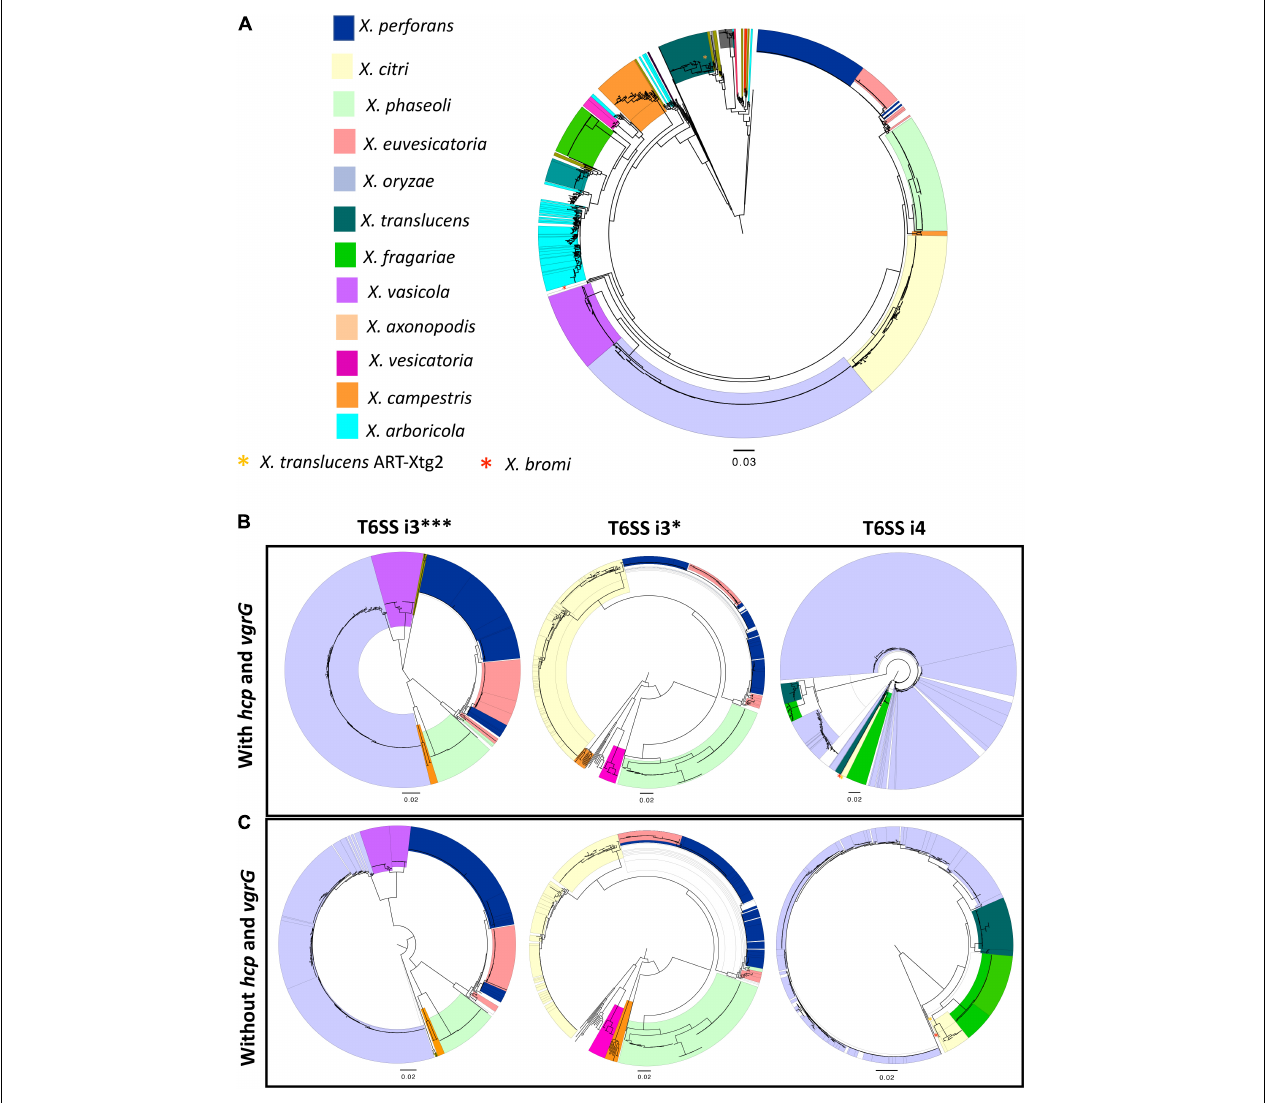
FIGURE 1 | Distribution of T6 clusters in the genus Xanthomonas. (A) Relationship among 1,577 Xanthomonas genomes, multilocus sequence analysis (MLSA) phylogeny of Xanthomonas spp. based on the concatenation of partial sequences of housekeeping genes atpD, dnaK, efP, fusA, fyuA, gapA, glnA, gltA, gyrB, lacF, lepA, and rpoD. (B) T6 core gene phylogeny of Xanthomonas spp. based on the concatenation of T6 core genes tssA , tssB , tssC , tssD (hcp) , tssE , tssF , tssG , tssH , tssI (vgrG) , tssJ (only in i4 cluster), tssK , tssL , and tssM. (C) T6SS core gene phylogeny of i3 ∗∗∗ , i3 ∗ , and i4 clusters in the absence of hcp and vgrG core genes. (B,C) T6 core gene phylogenies were generated using the automated multilocus sequence analysis pipeline (automlsa2). Midpoint rooted phylogenetic trees in maximum likelihood (ML) criterion were reconstructed using the IQ-TREE and branch support was determined using 1,000 bootstraps and 1,000 SH-aLRT bootstrap